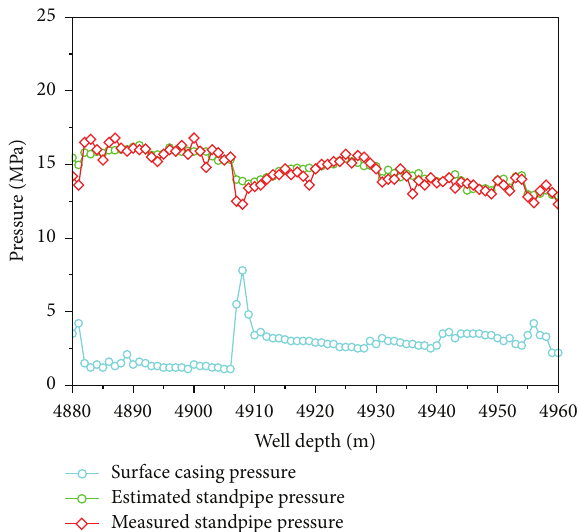
Figure 18: Wellbore pressure profiles simulated using traditional model and new model for different circulation time.